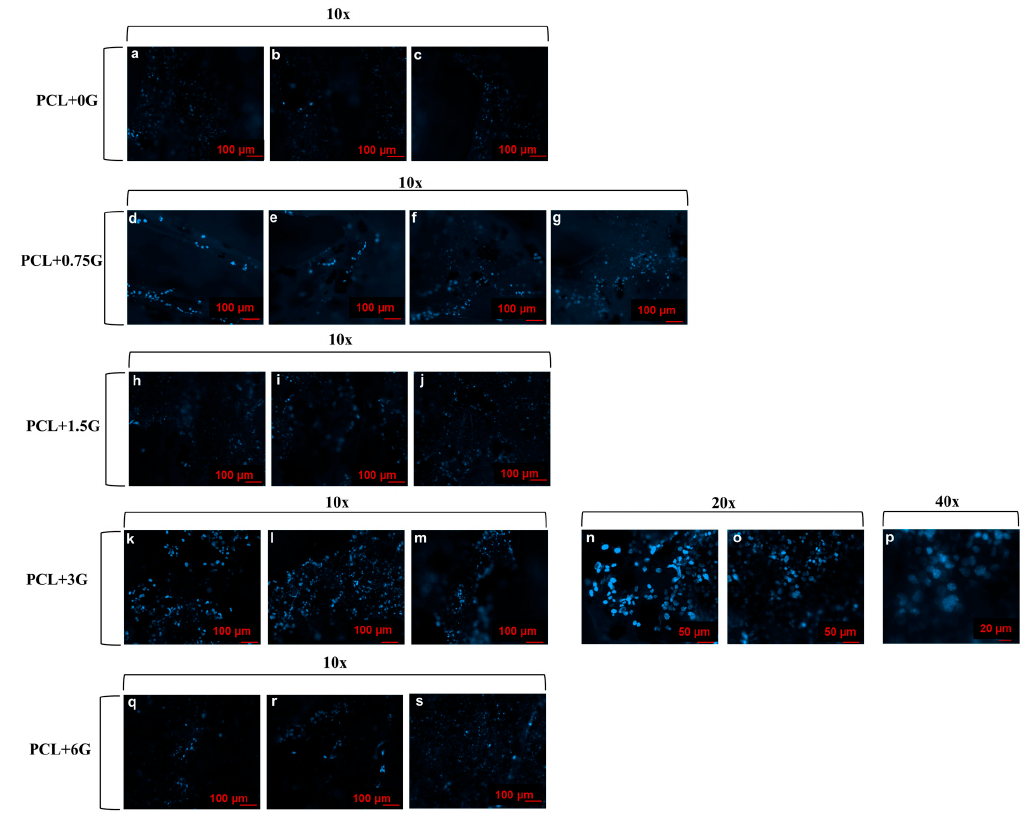
Figure 10. Wide-field fluorescence images for nuclei-stained HL-1 cells from random locations on PCL+0G (experimental control), PCL+0.75G, PCL+1.5G, PCL+3G, and PCL+6G scaffolds cultured under standard conditions for 3 days and acquired at several magnifications (see key). At least 3 random areas per DAPI-stained scaffold were imaged using Colibri 7 LED illumination at an exci- tation wavelength of 405 nm for 820 milliseconds. Images were captured at 1024 × 1024 pixels of resolution. Scale bar represents a 100 µm distance within images ( a – m ) and ( q – s ), a 50 µm distance within the images ( n,o ), and a 20 µm distance within image ( p ).